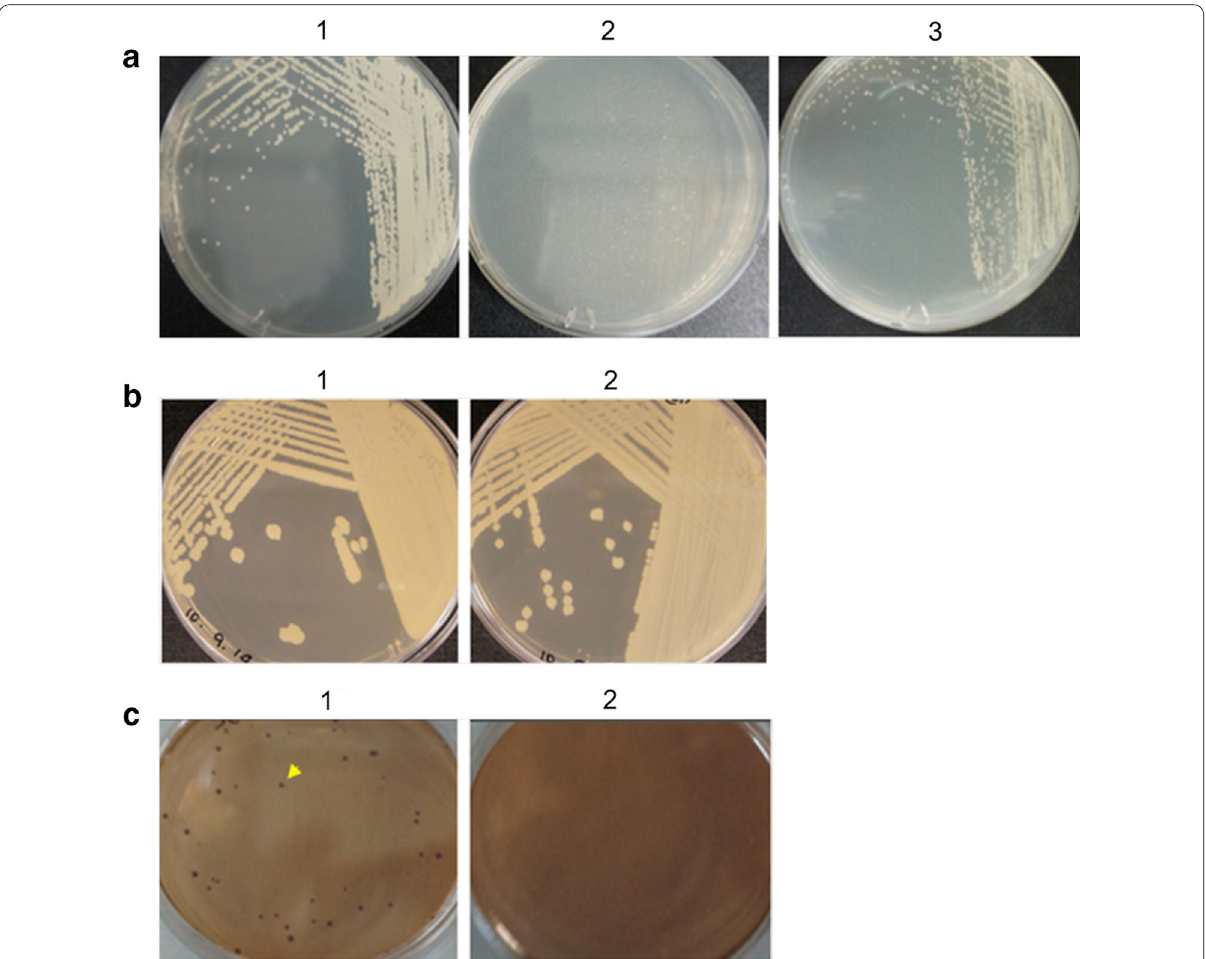
Fig. 1 Growth characteristics of SJP‑SNU. a Comparison of growth efficiency of SJP‑SNU and S. boulardii at 37 °C on YM agar plates (1: SJP‑SNU after 18 h, 2: S. boulardii after 18 h., 3: S. boulardii after 32 h.). b Anaerobic growth of SJP‑SNU on YM agar plates (1: Aerobic condition at 37 °C for 48 h., 2: Anaerobic condition at 37 °C for 48 h.). c Comparison of bile salt resistance of SJP‑SNU and S. boulardii cultured at 37 °C on MacConkey agar plates for 5 days (1: SJP‑SNU, 2: S. boulardii